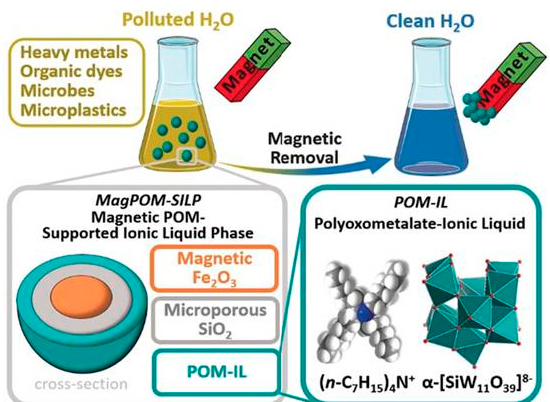
Figure 9. Schematic representation of multiple pollutants removal from water using magnetic polyoxometalate supported ionic liquid phases (taken from reference [55] with permission of John Wiley & Sons, Inc).